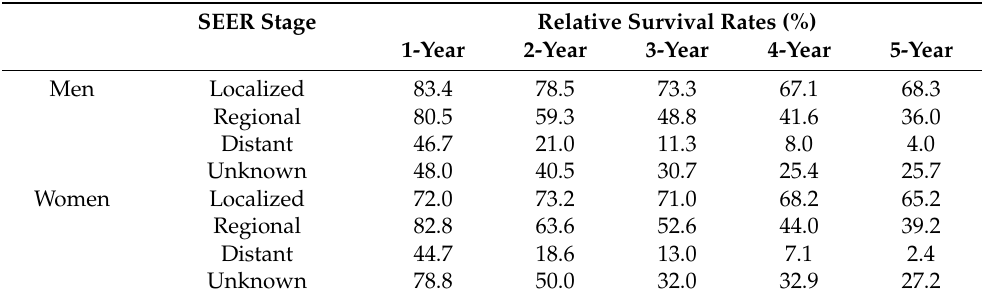
Table 6. Relative survival rates of patients with rectum signet-ring cell carcinoma between 1993 and